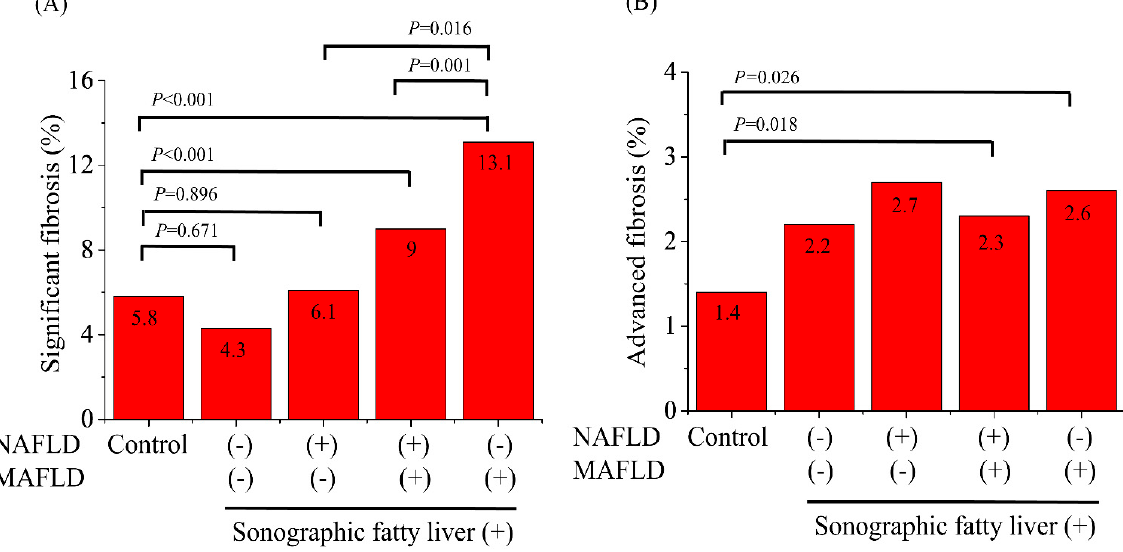
Figure 3. The prevalence of significant fibrosis ( ≥ 3.0 kPa) ( A ) and advanced fibrosis ( ≥ 3.6 kPa) ( B ) on magnetic resonance elastography among the healthy controls, and those with neither NAFLD nor MAFLD, NAFLD only, both NAFLD and MAFLD, and MAFLD only. Abbreviations: MAFLD, metabolic-associated fatty liver disease; NAFLD, non-alcoholic fatty liver disease.